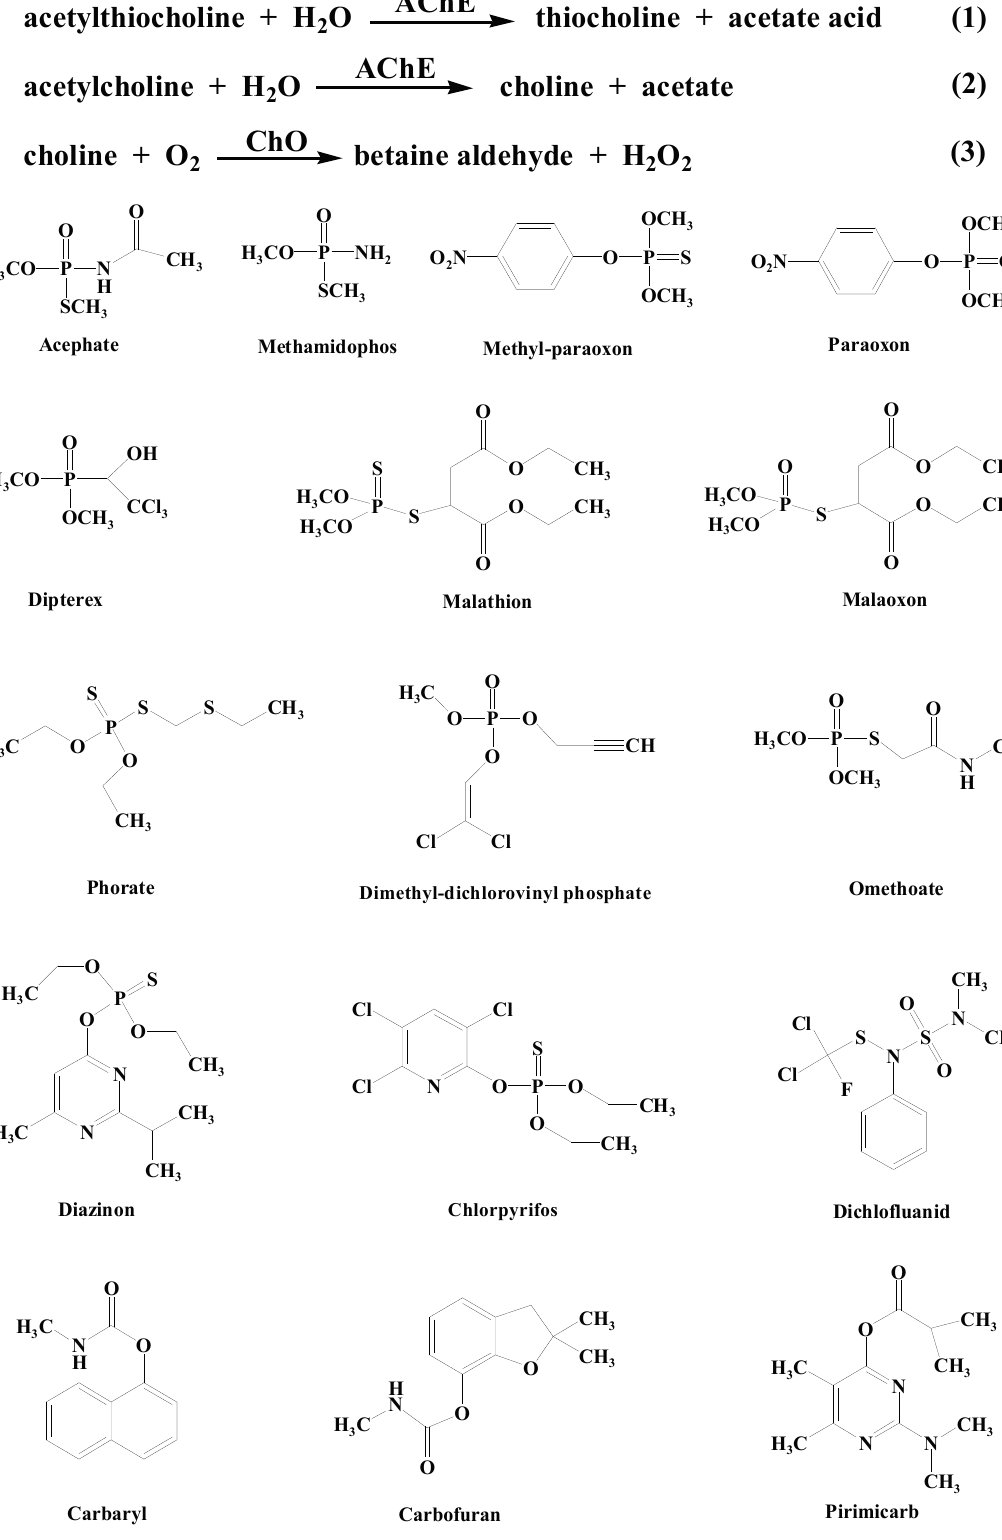
Figure 1. Structures of the main pesticides used as targets in AChE-based